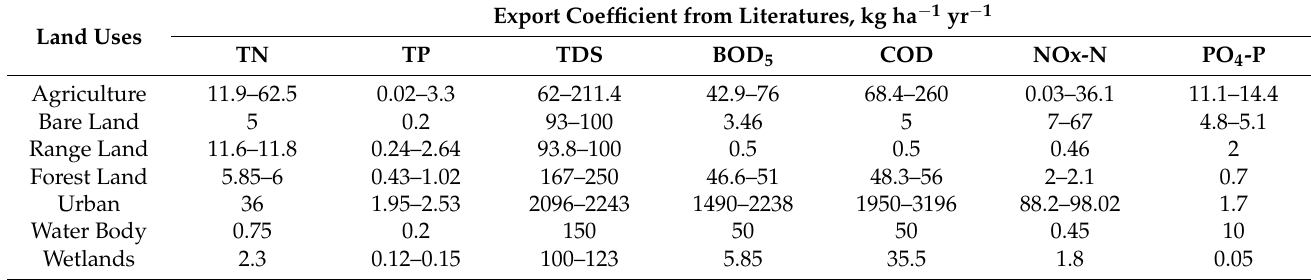
Table 9. Range of export coefficients after calibration of PLOAD for various land uses in LHW. Land